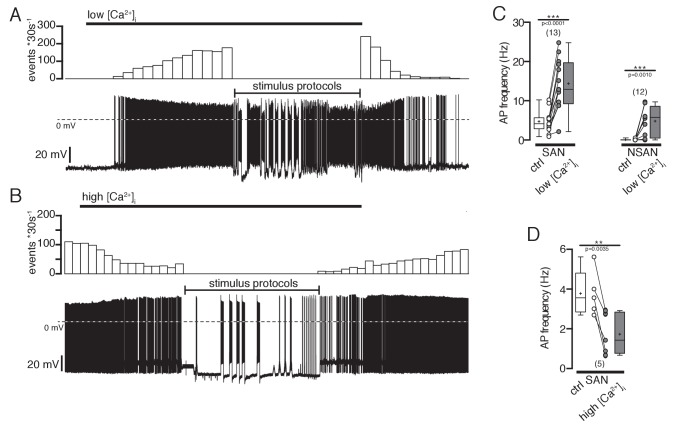
Effect of intracellular Ca2+ concentrations on action potential frequency of POMC neurons.(A and B) Original recordings of POMC neurons illustrating the effect of decreasing or increasing intracellular Ca2+ concentrations. (A) A silent POMC neurons started to generate action potentials with decreasing [Ca2+]i. The effect reverted to control levels at normal [Ca2+]i. (B) In a spontaneously active neuron, the AP frequency was reduced with increasing [Ca2+]i. The effect reversed at normal Ca2+ levels. (C) Action potential frequency of spontaneously active and silent POMC neurons at normal and low [Ca2+]i, respectively (paired t-test). (D) Action potential frequency of spontaneously active neurons at normal and high [Ca2+]i, respectively (paired t-test). SAN, spontaneously active neuron; NSAN, not spontaneously active neuron (F < 0.5 Hz). **p<0.01, ***p<0.001.